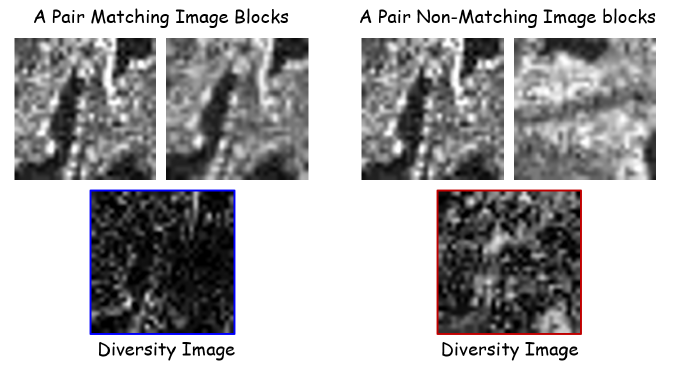
Figure 4. Diversity maps corresponding to a pair of matching image blocks and a pair of non- matching image